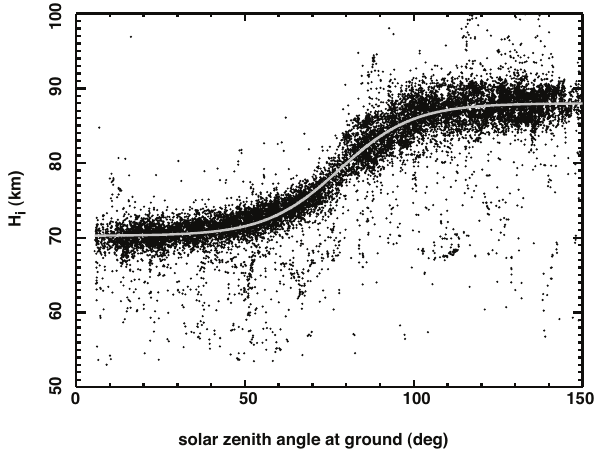
Fig. 4. Scatter plot of retrieved ionospheric height versus solar zenith angle at ground, for all 65000 height retrievals.